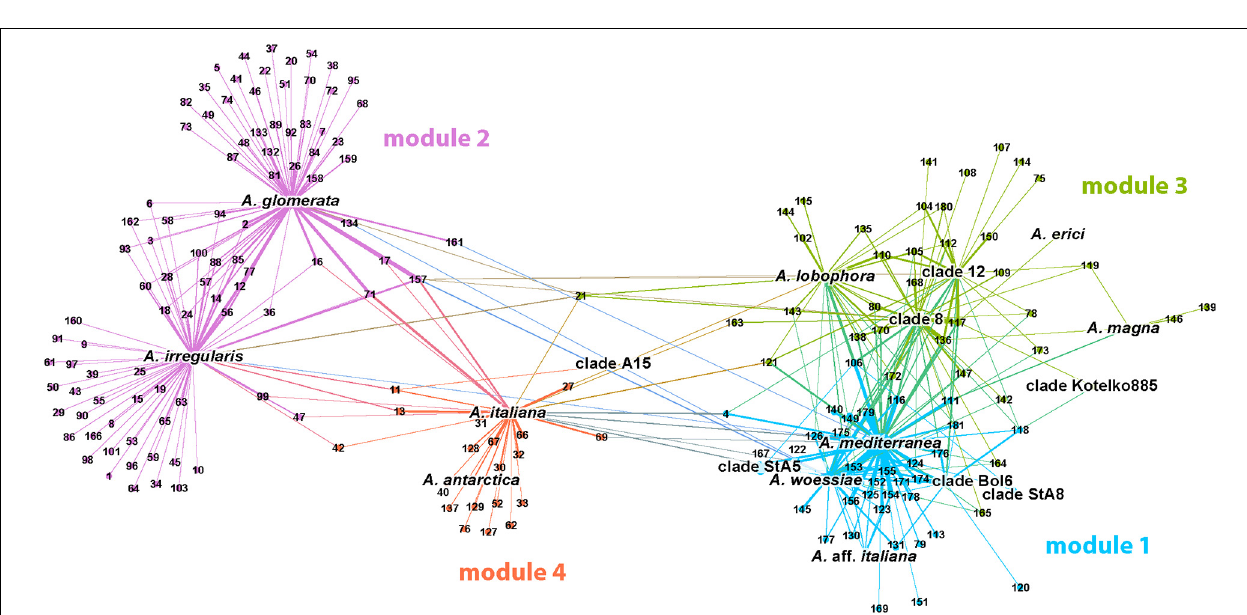
FIGURE 3 | Visualization of the photobiont-mycobiont (marked with photobionts species names and mycobionts OTU numbers, respectively) network resulting from the modularity analysis. No-overlap algorithm was used to spread nodes apart. Four major modules were found and they are distinguished by color.